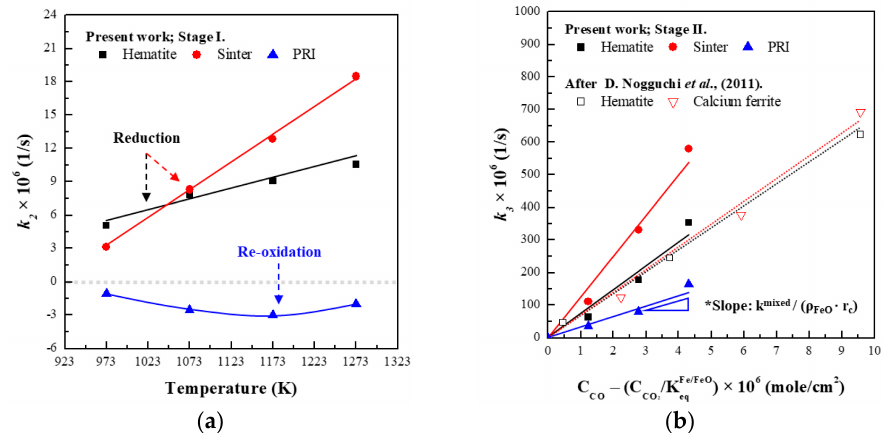
Figure 5. Changes in ( a ) k 2 in Stage I and ( b ) k 3 in Stage II ( k 2 : controlled by gaseous mass transport through the product layer; k 3 : mixed controlled).